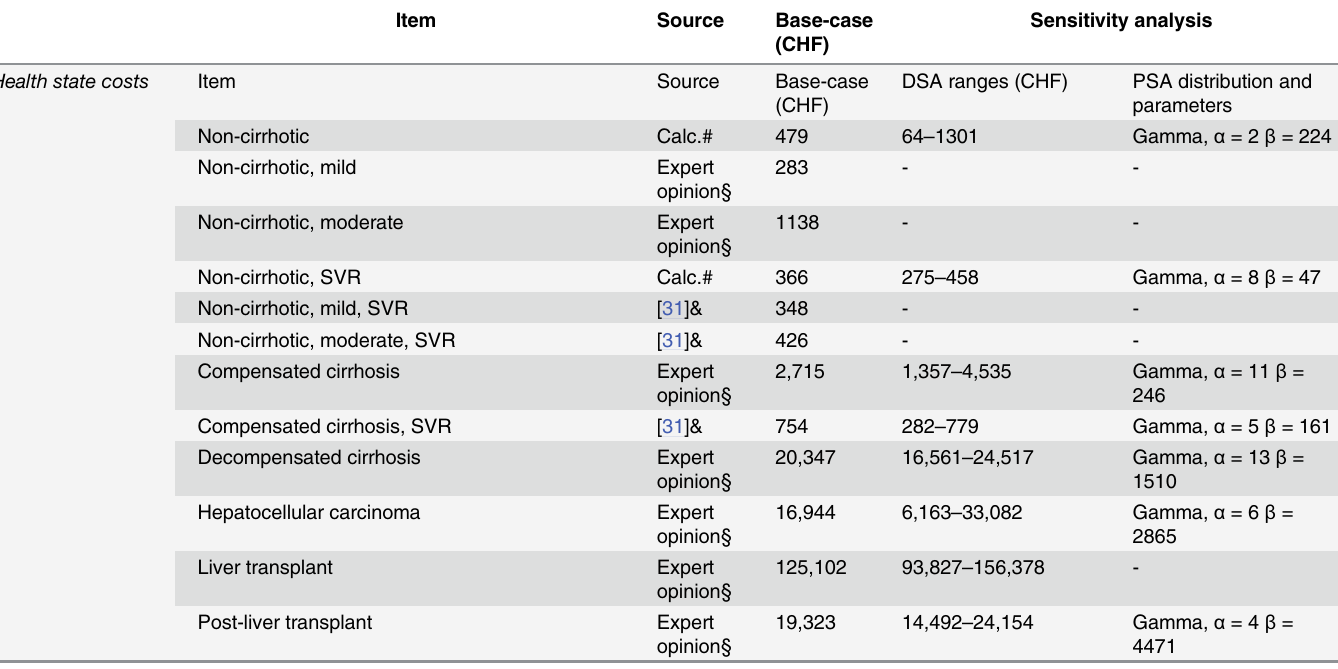
QALYs compared to no treatment, whereas interferon-eligible patients gained 0.6 QALYs compared to treatment with pegylated interferon alpha and ribavirin (S3 Table). In genotype 3, ICERs of interferon-ineligible patients were in the same range for treatment- naïve (CHF 34,826 per QALY) and treatment-experienced (CHF 45,935 per QALY) patients (Table 4). The limited difference in ICERs was due to moderately lower QALY gains in treat- ment-experienced patients (2.1 vs. 2.5 QALY). We also noted a large difference in the cost per QALY gained of two different sofosbuvir-containing regimens, versus the same comparator, for the treatment of genotype 3, interferon-eligible patients (S4 Table). A treatment strategy of sofosbuvir in combination with pegylated interferon alpha and ribavirin for 12 weeks was clearly more cost effective than a 24 week-alternative without interferon in treatment-experi- enced (ICERs CHF 16,235 per QALY vs. CHF 74,805 per QALY, respectively) and treatment- naïve patients (ICERs CHF 38,512 per QALY vs. CHF 91,570 per QALY) (Table 4). Total and disaggregated costs and QALYs gained per patient are presented in Table 5 for ge- notype 1. Cost and QALY results for the other HCV genotypes are presented in S3 – S5 Tables. In genotype 1 treatment-naïve patients, drug costs for sofosbuvir-containing regimens were substantially higher than drug costs for comparator strategies (e.g. CHF 62,862 for sofosbuvir +pegylated interferon alpha+ribavirin vs. CHF 20,454 for pegylated interferon alpha+- ribavirin). Monitoring costs were generally lower for sofosbuvir-containing regimens